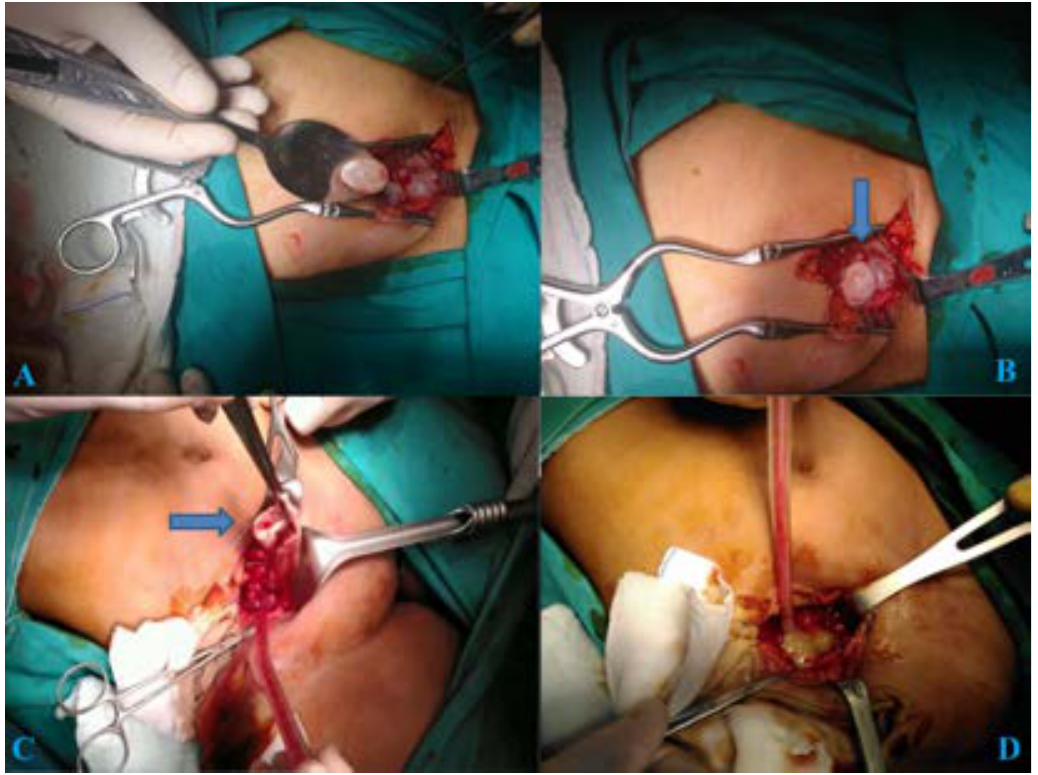
Fig. 4 – Pelvic iliofemoral hydatid cyst surgery.